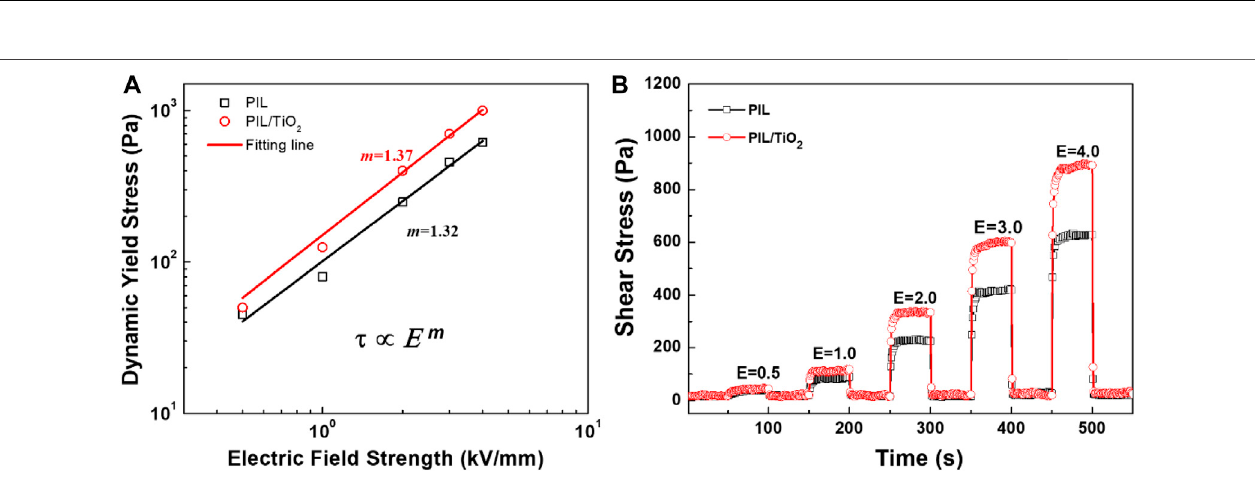
FIGURE6 | DynamicyieldstressoftheER fl uidsasafunctionofelectric fi eldstrength (A) andshearstressoftheER fl uidsatasquarepulsedelectric fi eld(unit:kV/mm) (B) .